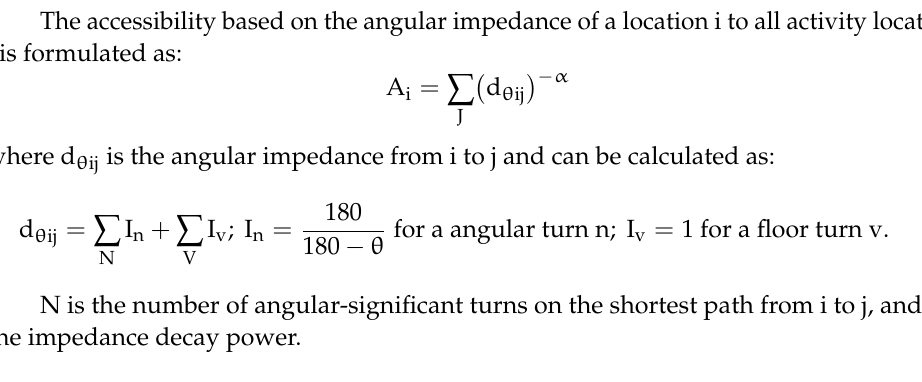
Figure 10. Angular impedance of traveling paths and accessibility estimation with α =